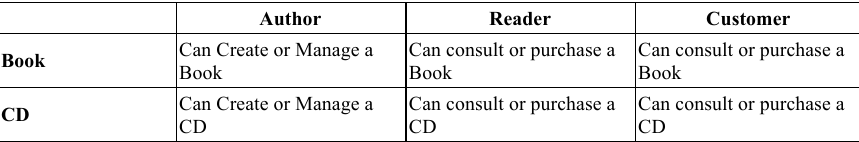
Table 3. User’s matrix of the Online Library study